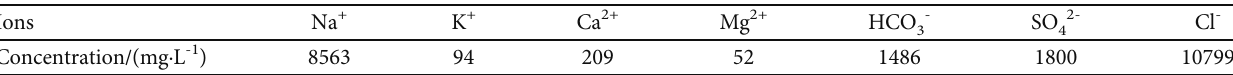
Table 3: Composition of the formation brine.